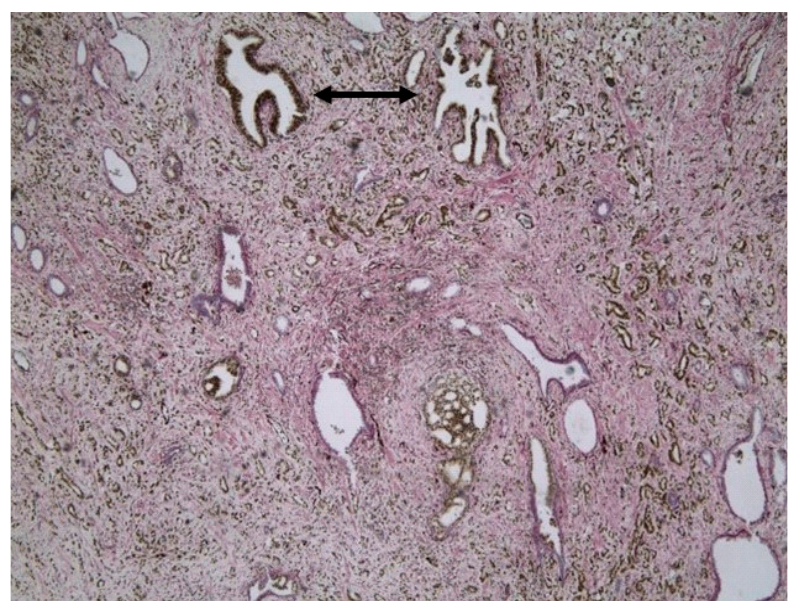
Figure 6. Two HGPIN foci with total PTEN loss and simultaneous ERG positivity (arrows) and adjacent high-grade invasive carcinoma [in the form of the cribriform cancerous gland (pattern 4) and single cells (pattern 5)] with total PTEN loss (×40).